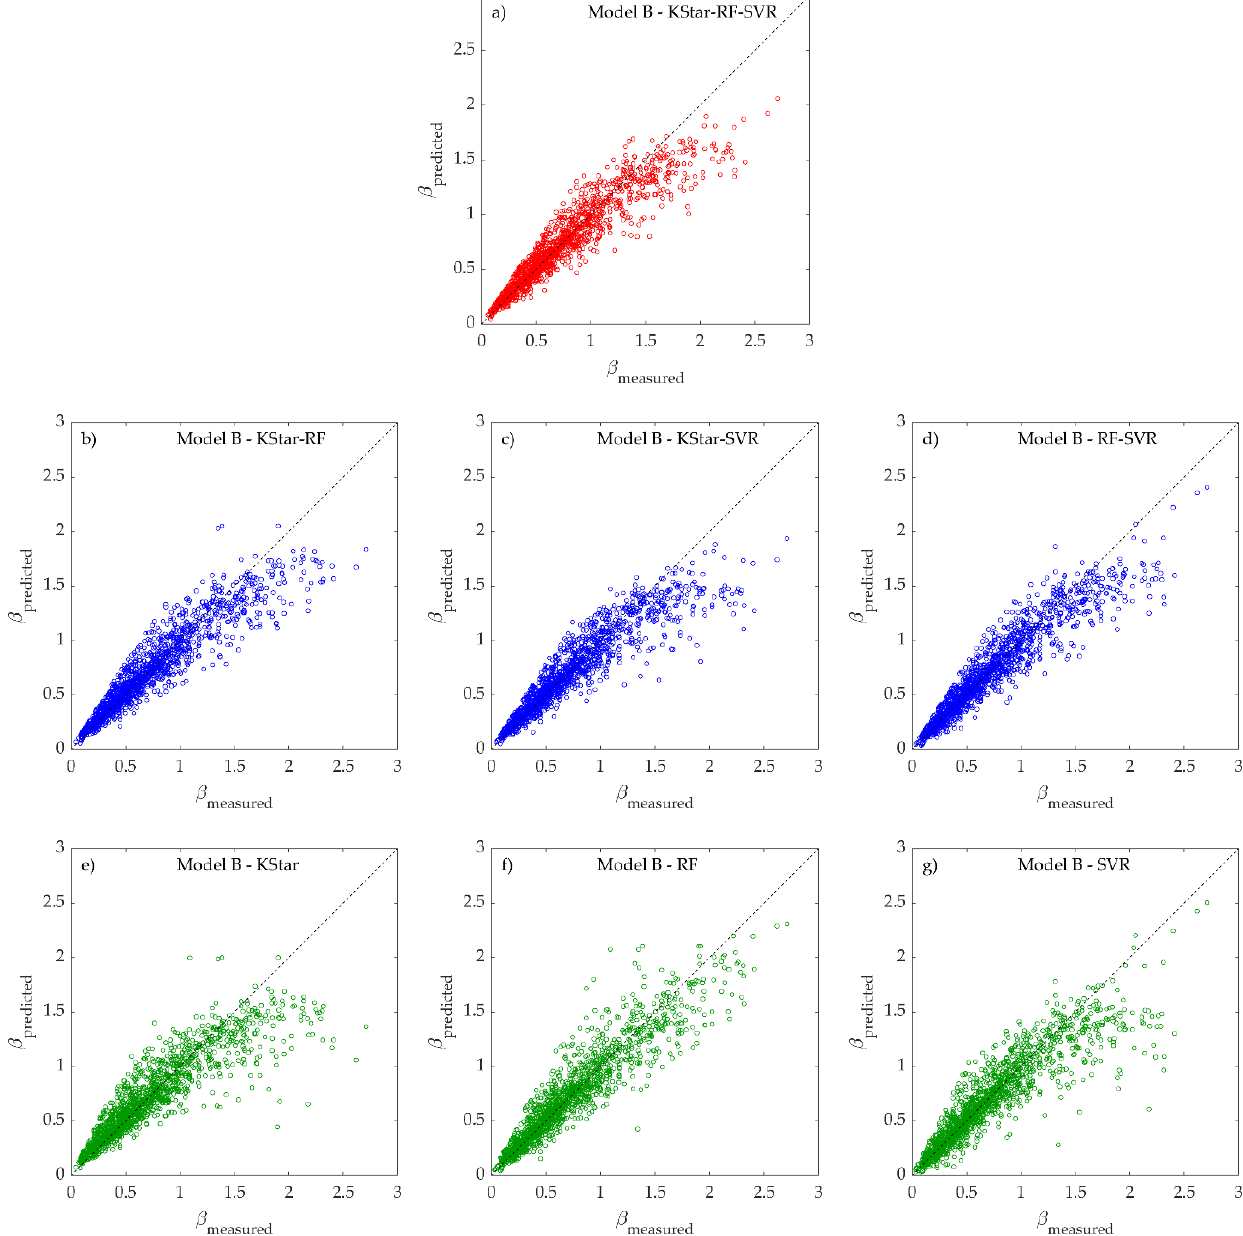
Figure 7. Model B:  predicted versus  measured. Figure 7. Model B: β predicted versus β measured